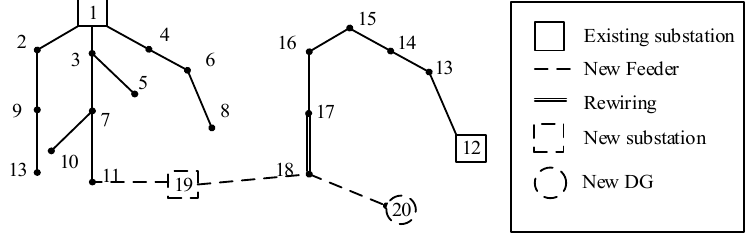
Figure 2. Example of an active distribution network planning scheme. The benefits of the substation construction project (proj.5) depend on the completion of the substation supporting project (proj.2). If proj.2 has not yet been completed, then